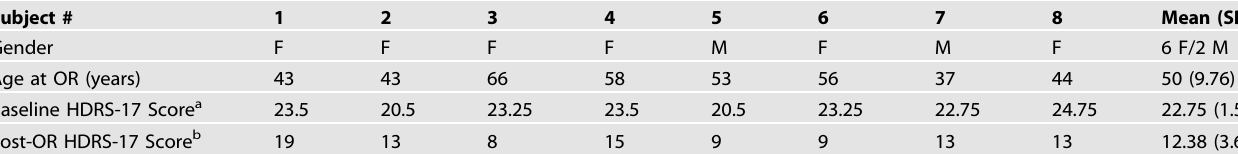
Table 1. Sample characteristics.